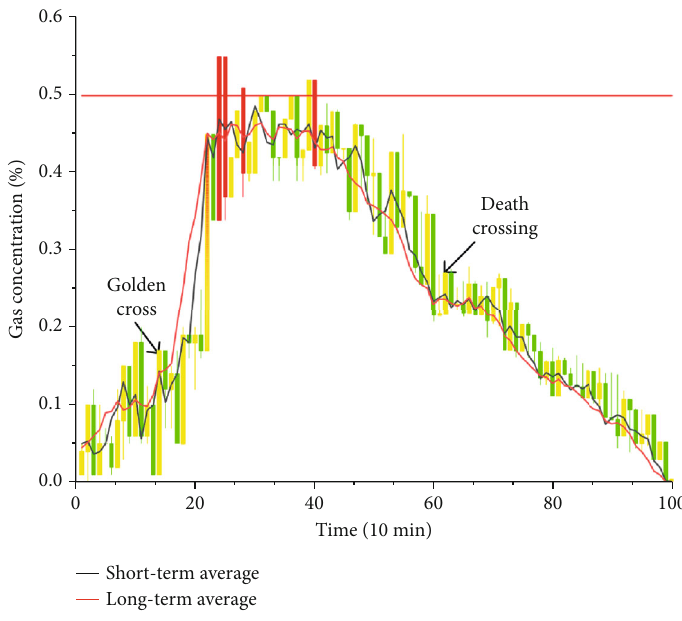
Figure 6: MA diagram of gas concentration.